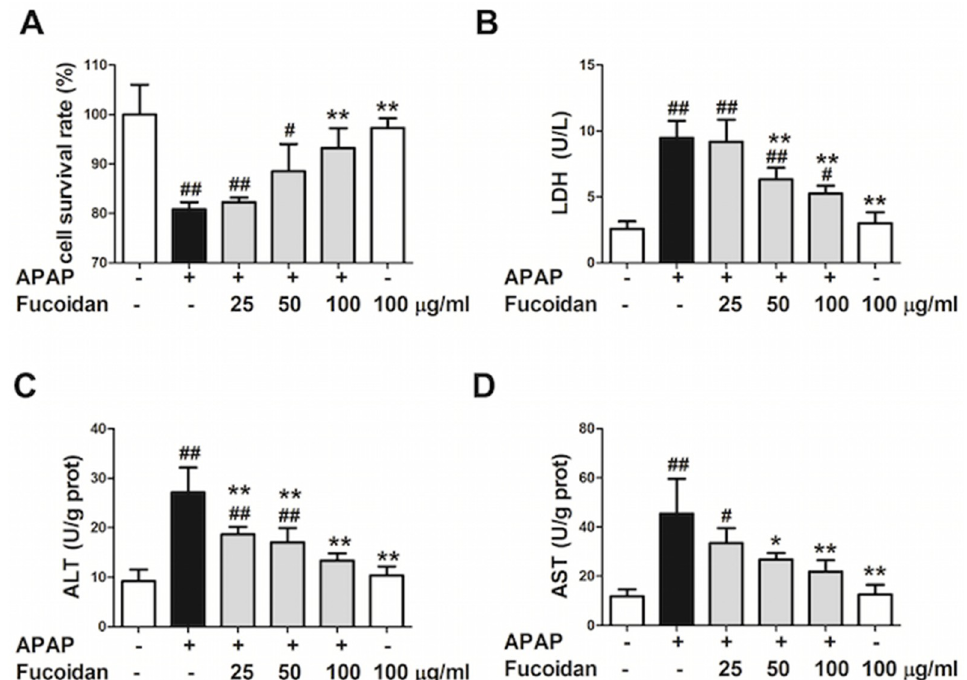
Figure 4. Effect of fucoidan on APAP-induced acute injury in HL-7702 cells. Cells were treated with various concentrations of fucoidan (25, 50, or 100 µ g/mL) for 4 h and subsequently stimulated with APAP (20 mM) for 24 h. ( A ) MTT assay was used to observe the survival rate of HL-7702 cells. ( B ) The levels of lactate dehydrogenase (LDH), ( C ) ALT, and ( D ) AST were determined to evaluate the damage of cells. Similar results were obtained from three independent experiments. All results were expressed as mean ± SD, n = 3, # p < 0.05, ## p < 0.01 versus control group; * p < 0.05, ** p < 0.01 versus APAP-treated group.